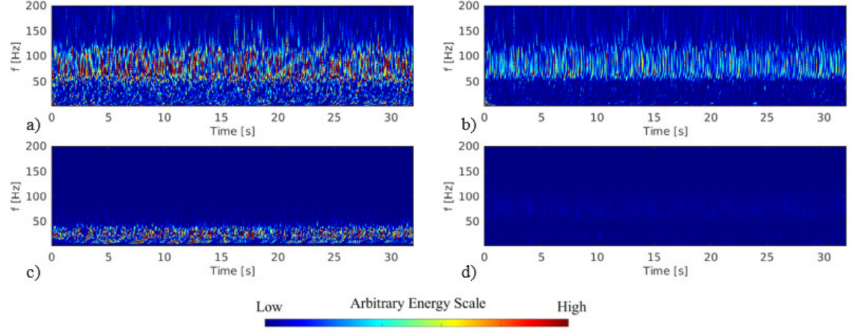
Figure 7. Continuous wavelet transforms of ( a ) Case 10—Signal of the wake velocity behind the first cylinder free to vibrate, ( b ) Case 11—Signal of the wake velocity behind the second cylinder free to vibrate, ( c ) Case 10—Acceleration signal of the first cylinder free to vibrate and ( d ) Case 11—Acceleration signal of the second cylinder free to